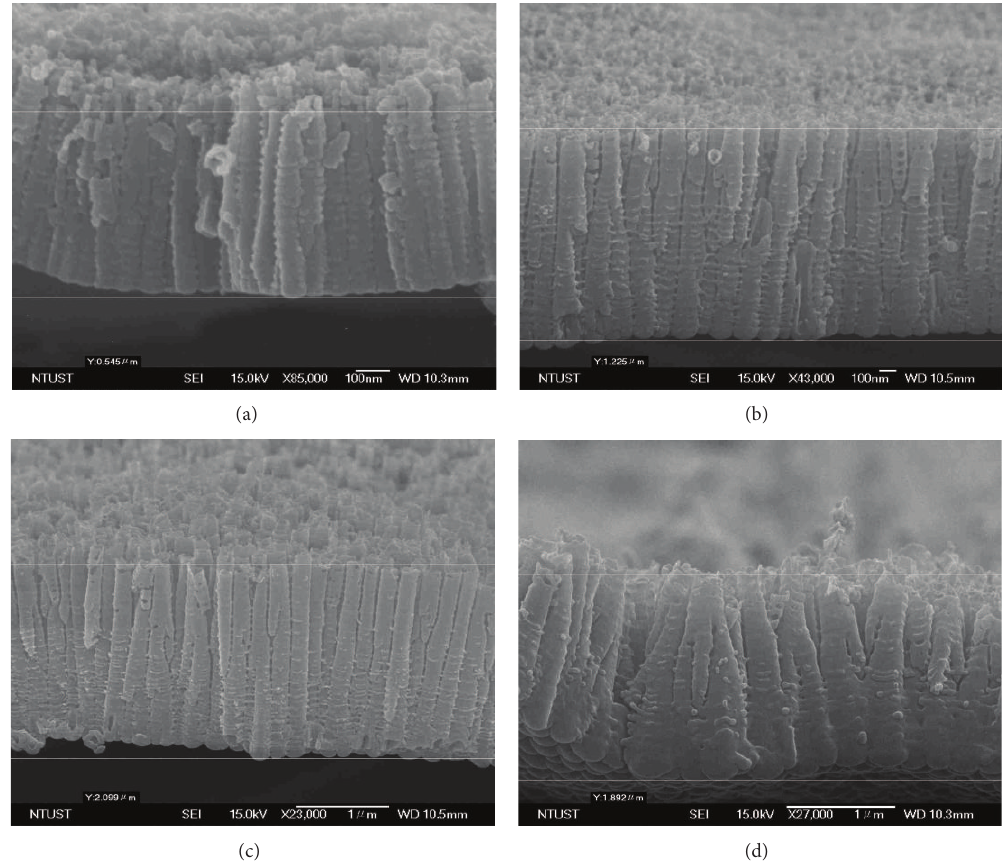
Figure 3: Front view of SEM images of TNT synthesized at different anodization voltages: (a) 10V, (b) 20 V, (c) 30V, and (d)